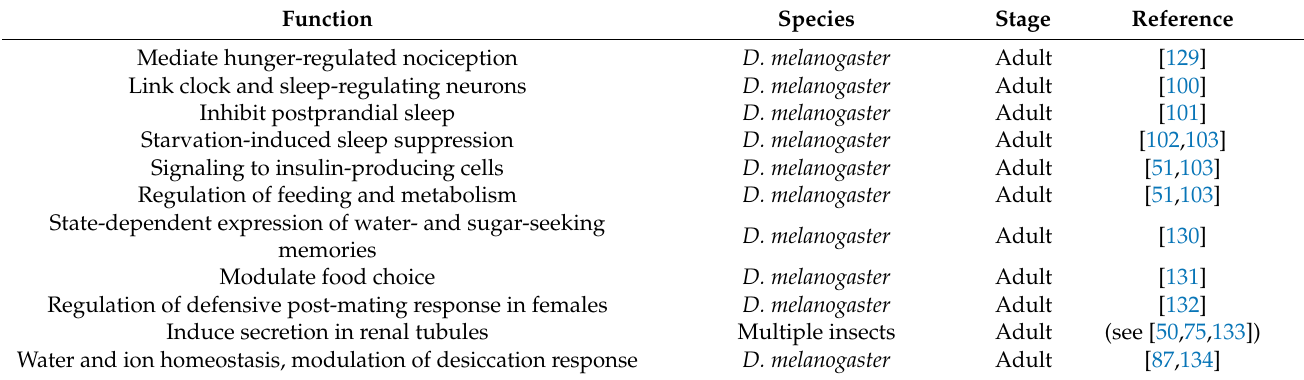
Table 2. Functional roles of LK signaling in